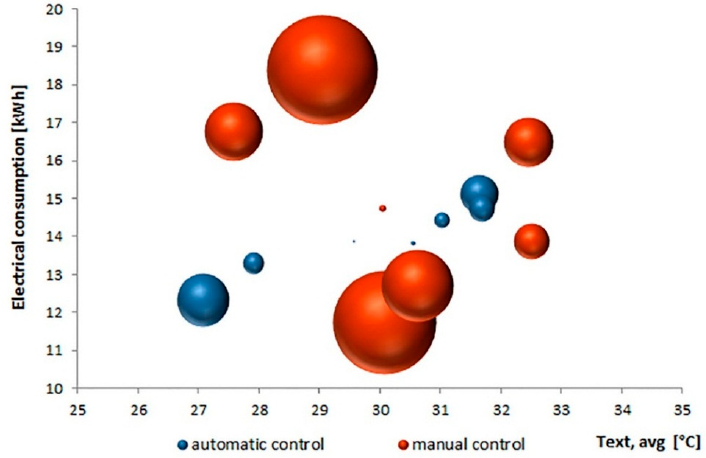
Figure 9. Energy consumption as a function of external average temperature.